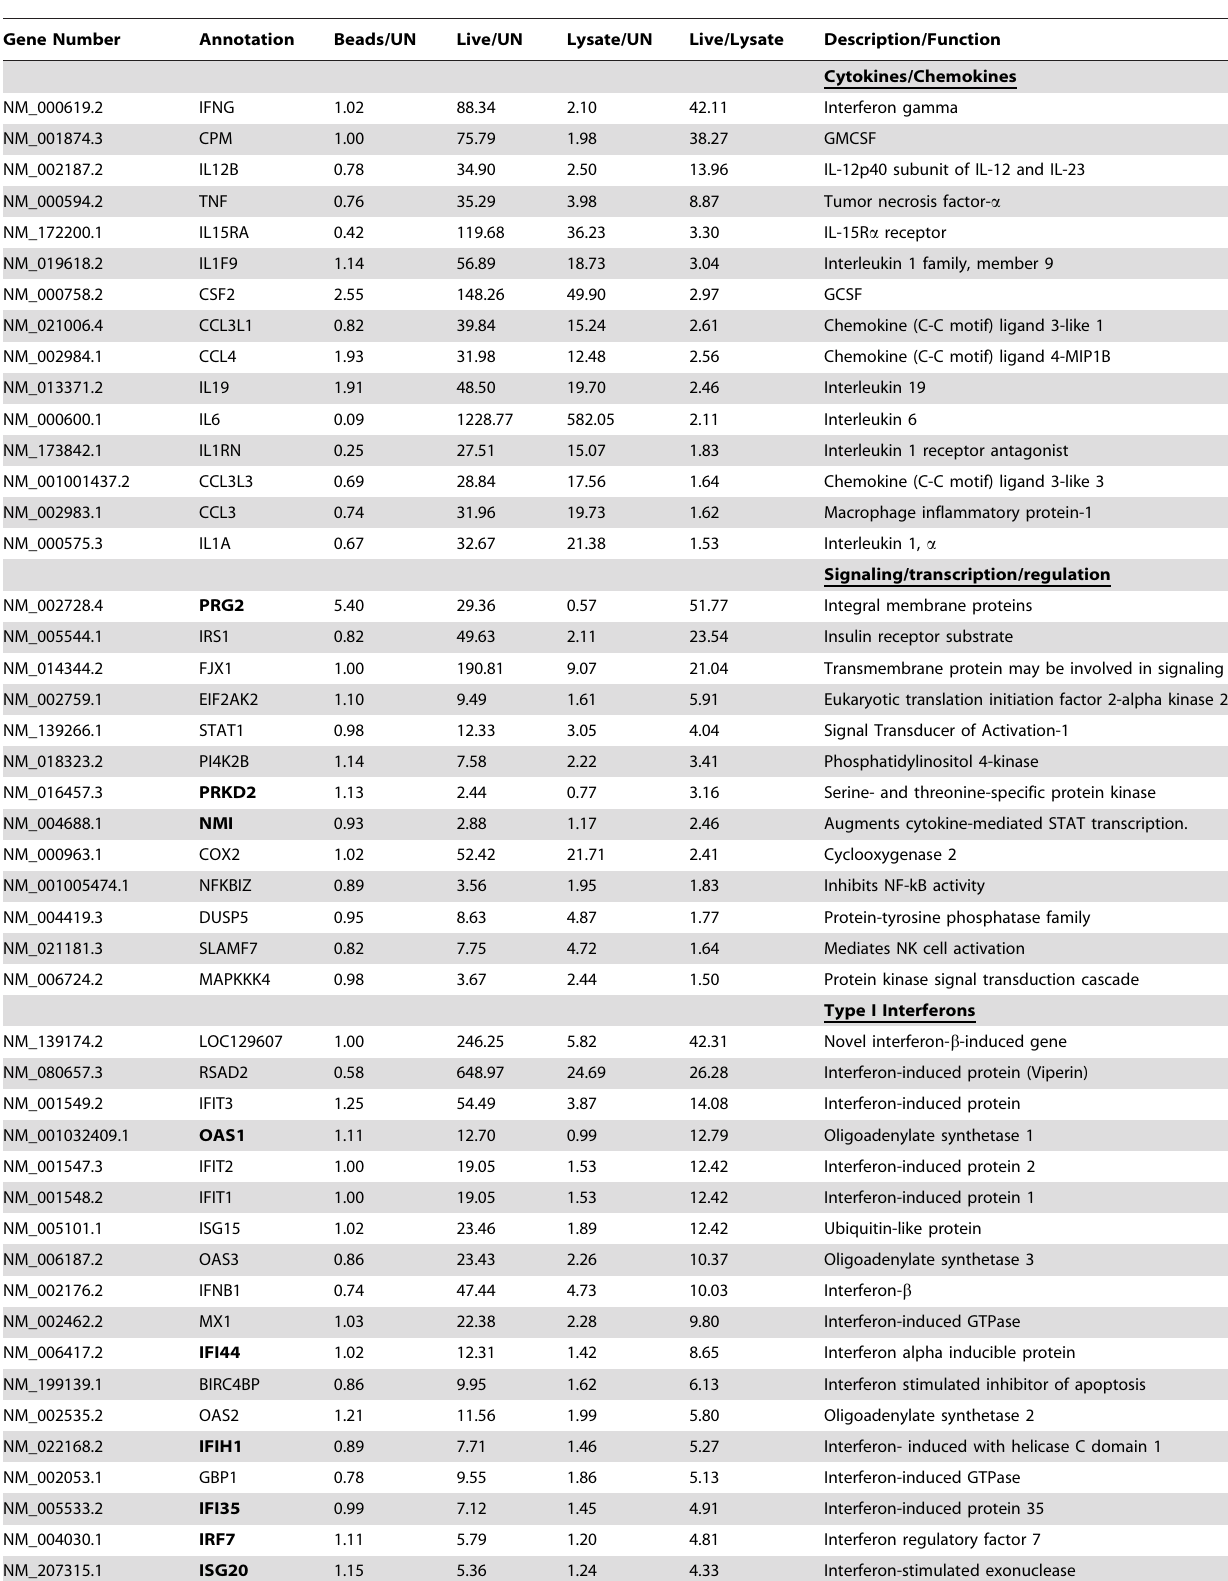
Table 1. Genes classified as being either more intensely or exclusively up-regulated in peripheral blood mononuclear cells (PBMCs) stimulated with live Borrelia burgdorferi (Bb) MOI (10:1) in comparison to similar concentrations of borrelial lysates.